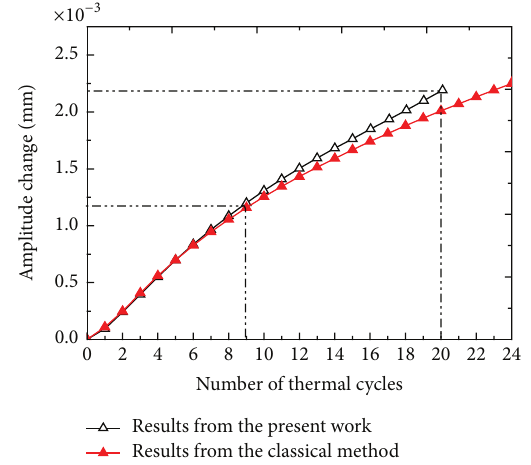
Results from the present work Results from the classical Figure 7: The comparison of amplitude change between two